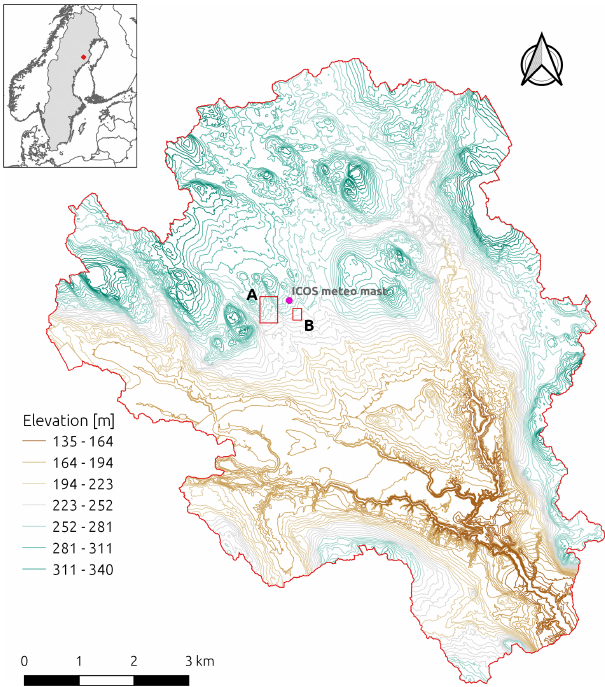
Figure 1. The Krycklan catchment and the location of the two study areas where the groundwater wells were installed (red squares) at points A (in C6) and B (S-transect in C2). The location of the ICOS station is marked by a point (north of area B). The inset shows the location in of the Krycklan catchment in northern Sweden. See Fig. 2 for a more detailed map of the study areas. Datum from SWERREF99 TM –